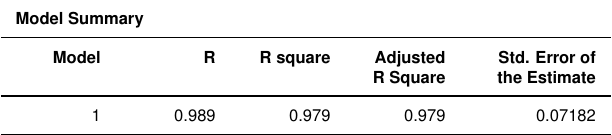
Table 4. Calculation of sensitivity using multiple regression analysis.